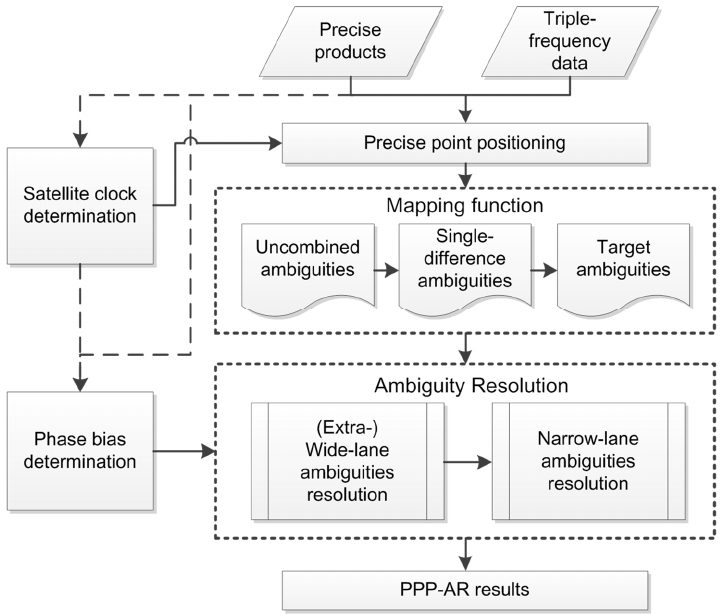
Figure 1. Flowchart of triple-frequency precise point positioning ambiguity resolution (PPP-AR). The